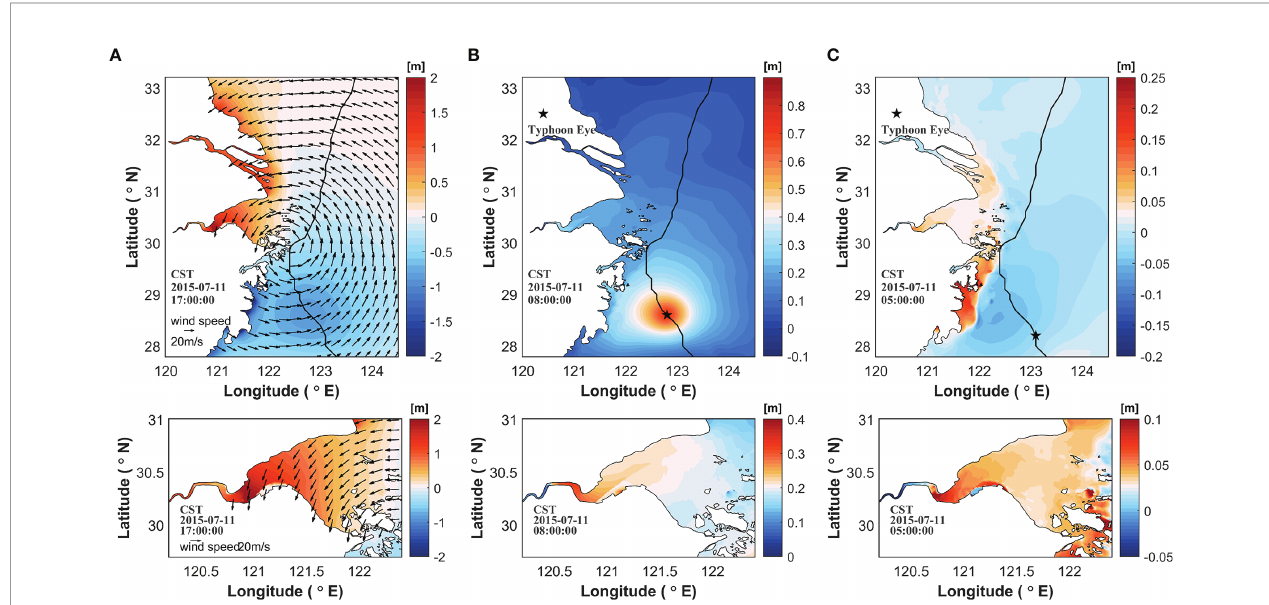
FIGURE 8 | (A) Wind speed and wind-induced surge at 17:00 on July 11. Vectors indicate wind speeds and contours indicate surges. (B) Pressure-induced surge at 00:00 on July 11. (C) Wave-induced surge at 21:00 on July